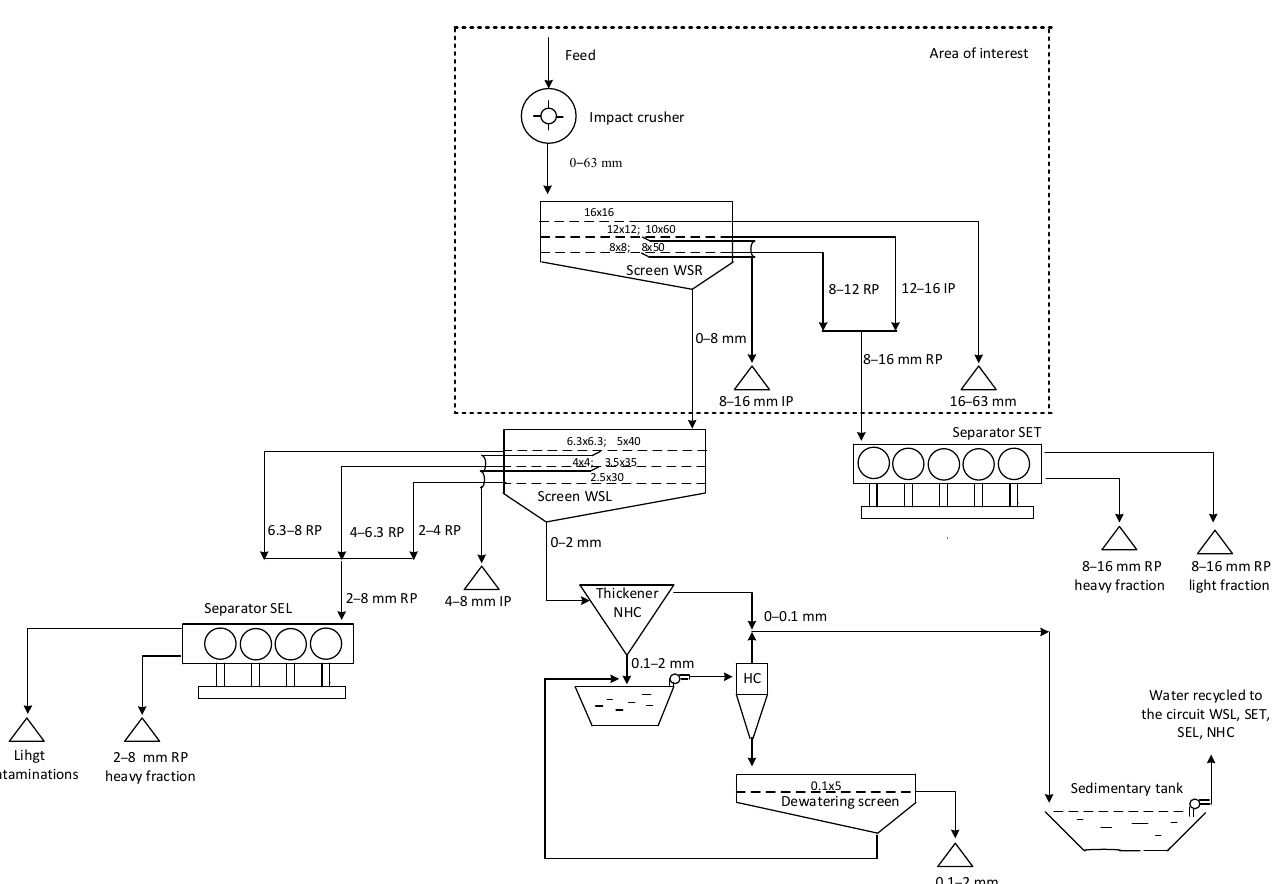
Figure 2. A simplified flow diagram of the installation for the mineral aggregates refinement in the Imielin Dolomite Mine.